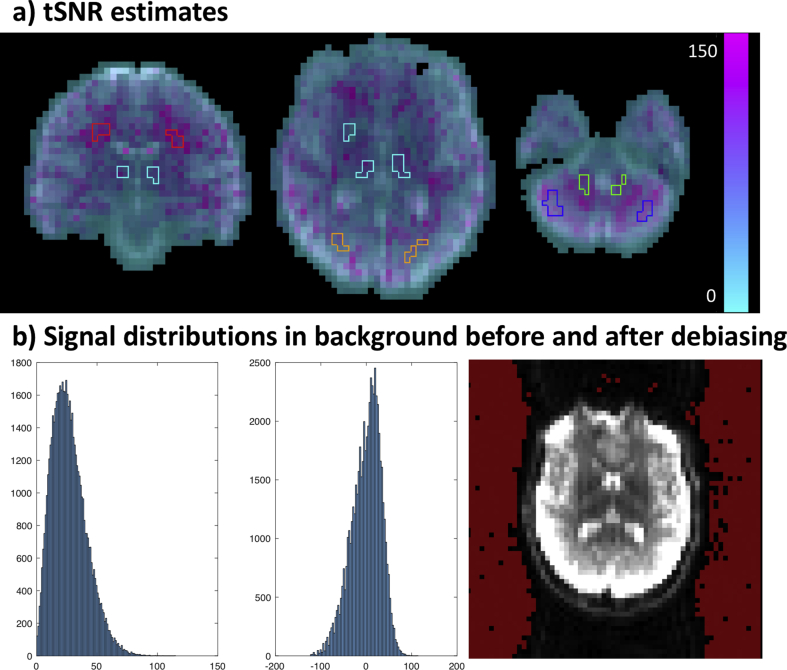
a) estimated temporal SNR (tSNR). The background is an S0 image, and the ROIs are indicated with outlines: mWM (red), oWM (orange), cWM (green), dGM (cyan), and cGM (blue). b) Distribution of the signal prior to and after bias correction. The voxels identified as noise-only voxels are shown in red.